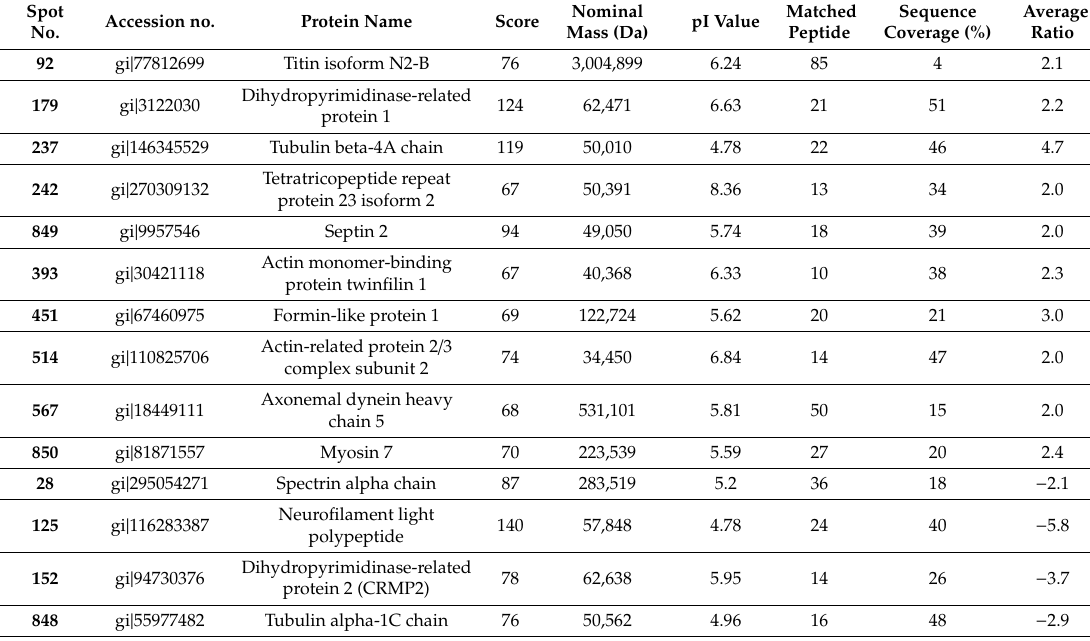
Table 3. Di ff erentially expressed proteins related to cell structure and morphology after entacapone treatment in the